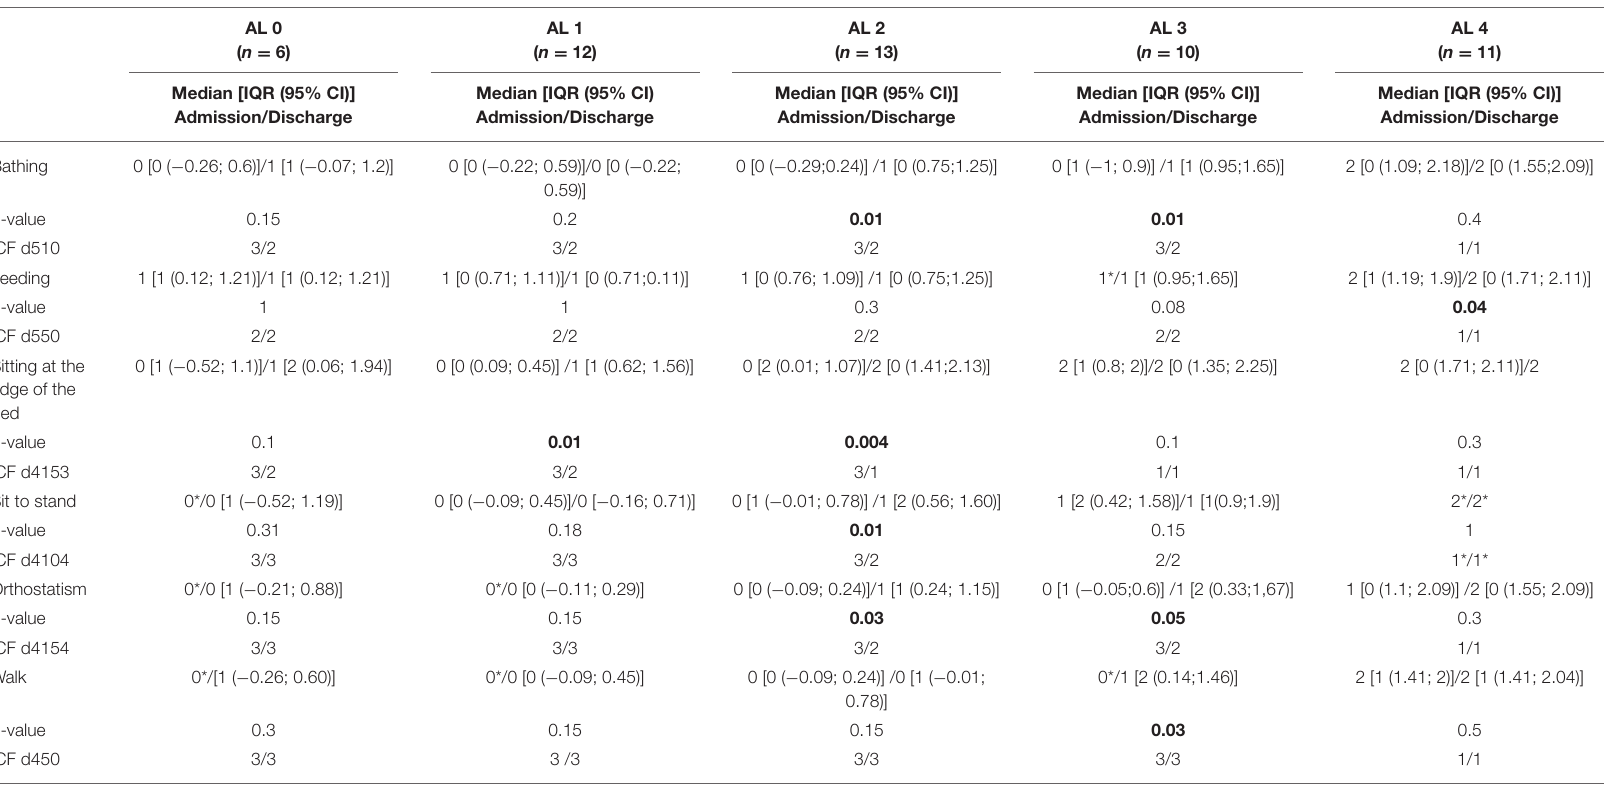
TABLE 8 | Descriptive outcomes from HPMQ in NEMP admission and discharge, their re-codification into ICF performance qualifier, and comparison of these two time points through Wilcoxon Signed Rank Test. Data from each AL